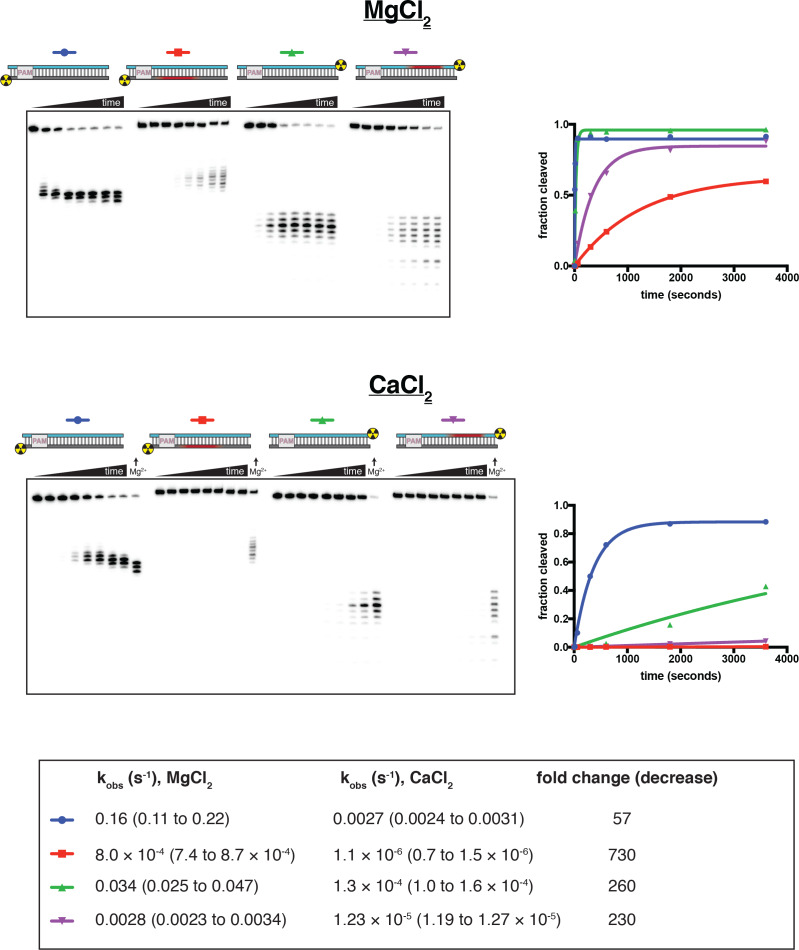
Cleavage at phosphorothioates can be selectively slowed by substitution of CaCl2 for MgCl2.100 nM AsCas12a and 120 nM crRNA were incubated with 1 nM radiolabeled duplex DNA target at 37°C, followed by quenching (at timepoints 0, 5 s, 15 s, 1 min, 5 min, 10 min, 30 min, 1 hr) and resolution by denaturing PAGE. Substrate diagrams are colored as in Appendix 2—figure 2—figure supplement 1. The top panel shows the experiment done in cleavage buffer with 5 mM MgCl2. The bottom panel shows the experiment done in cleavage buffer with 5 mM CaCl2—at the end of each time course on this gel, the 1-hr timepoint of the MgCl2 experiment is included for visual comparison. ‘Fraction cleaved’ is defined as (sum of the volume of all bands below the uncleaved band)/(total volume in lane). Data were fit to an exponential decay (y = (y0-plateau)*exp(-k*x)+plateau), with y0 constrained to 0. The plateau value was constrained to 1 for those time courses that did not exceed fraction cleaved = 0.5 by the 1-hr timepoint. Rate constants (with 95% confidence intervals) are shown in the table below the gels. It is unclear why cleavage of a phosphorothioated TS occurs more rapidly than cleavage of a phosphorothioated NTS, although it is conceivable that this is an intrinsic feature of the enzyme cleavage pathway when the chemical transformation is rate-limiting. Considering only effects on the NTS, the calcium substitution decreases the phosphodiester cleavage rate by a factor of 57 and decreases the phosphorothioate cleavage rate by a factor of 730, resulting in a 13-fold increase in selectivity for phosphodiesters over phosphorothioates and yielding kinetics slow enough to resolve by manual pipetting.